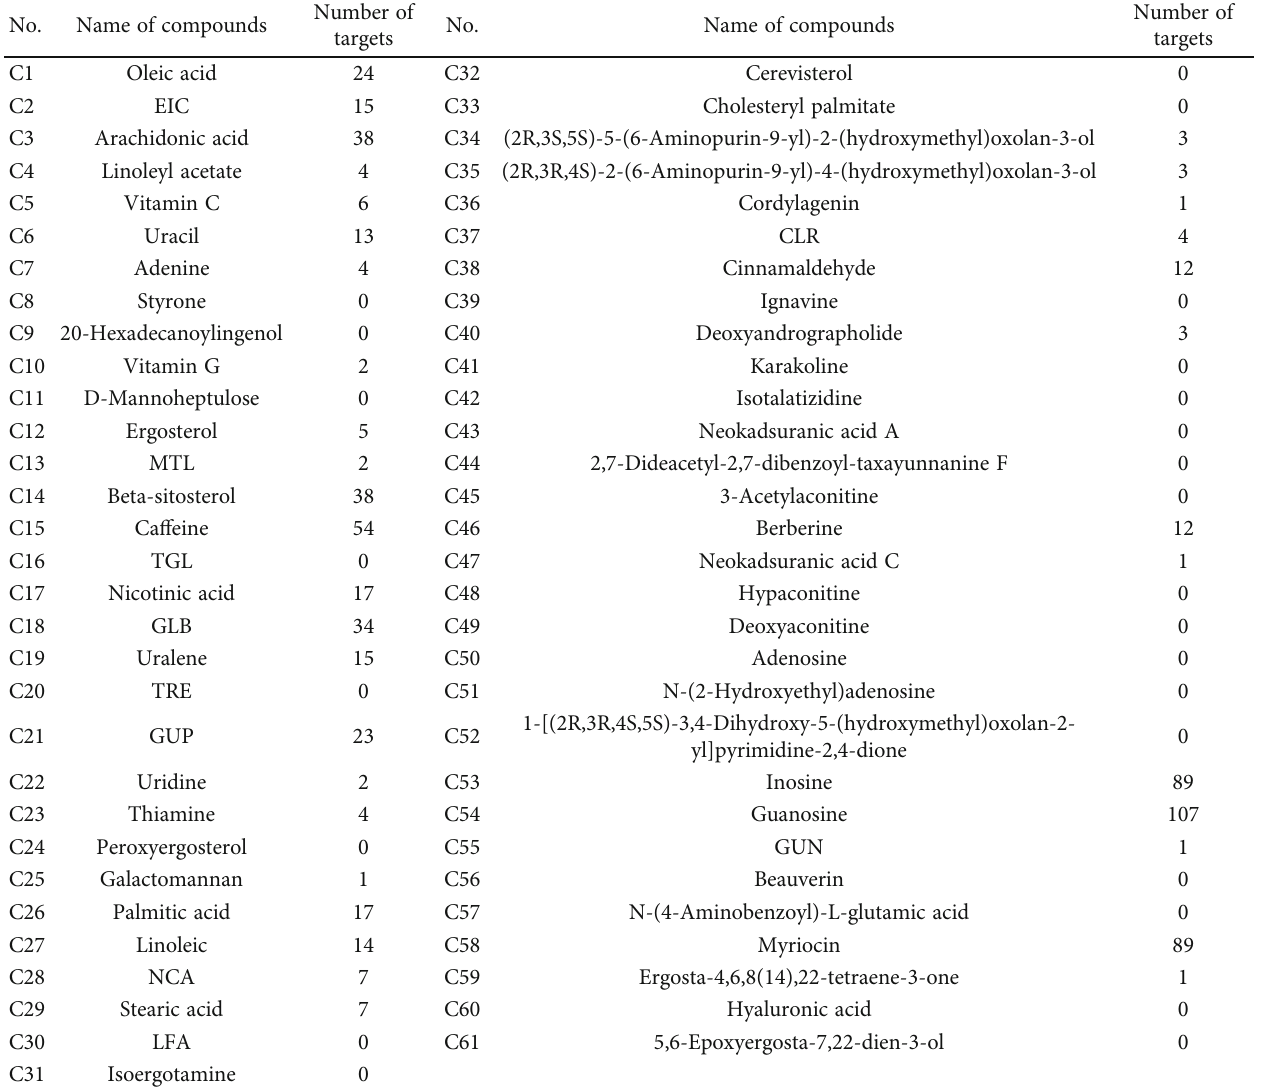
Table 1: Candidate compounds of cordyceps